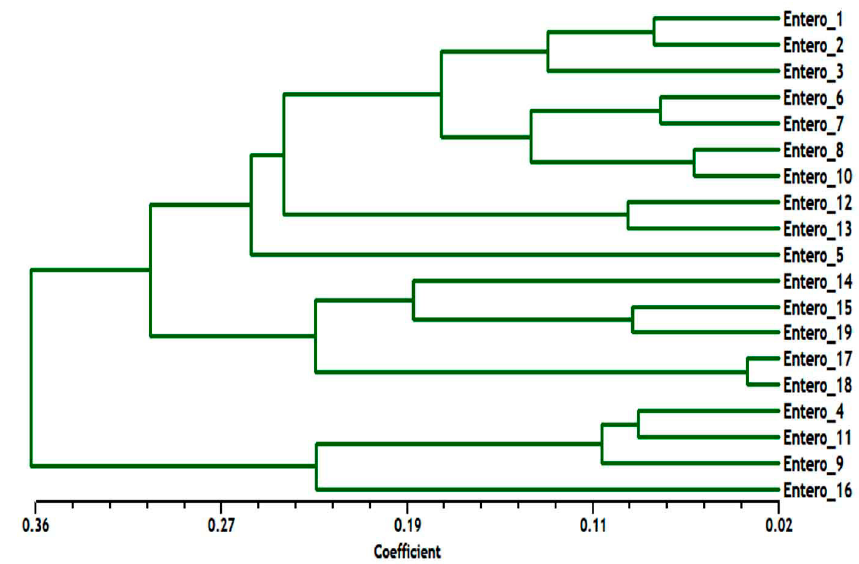
Fig. 6. Dendrogram analysis among nineteen Enterococcus spp . isolates generated with five rep-PCR primers, E. faecium samples included (Entero-4, 9, 11 and 16), E. faecalis samples included (Entero-1, 2, 3, 5, 6, 7, 8, 10, 12, 13, 14, 15, 17, 18 and